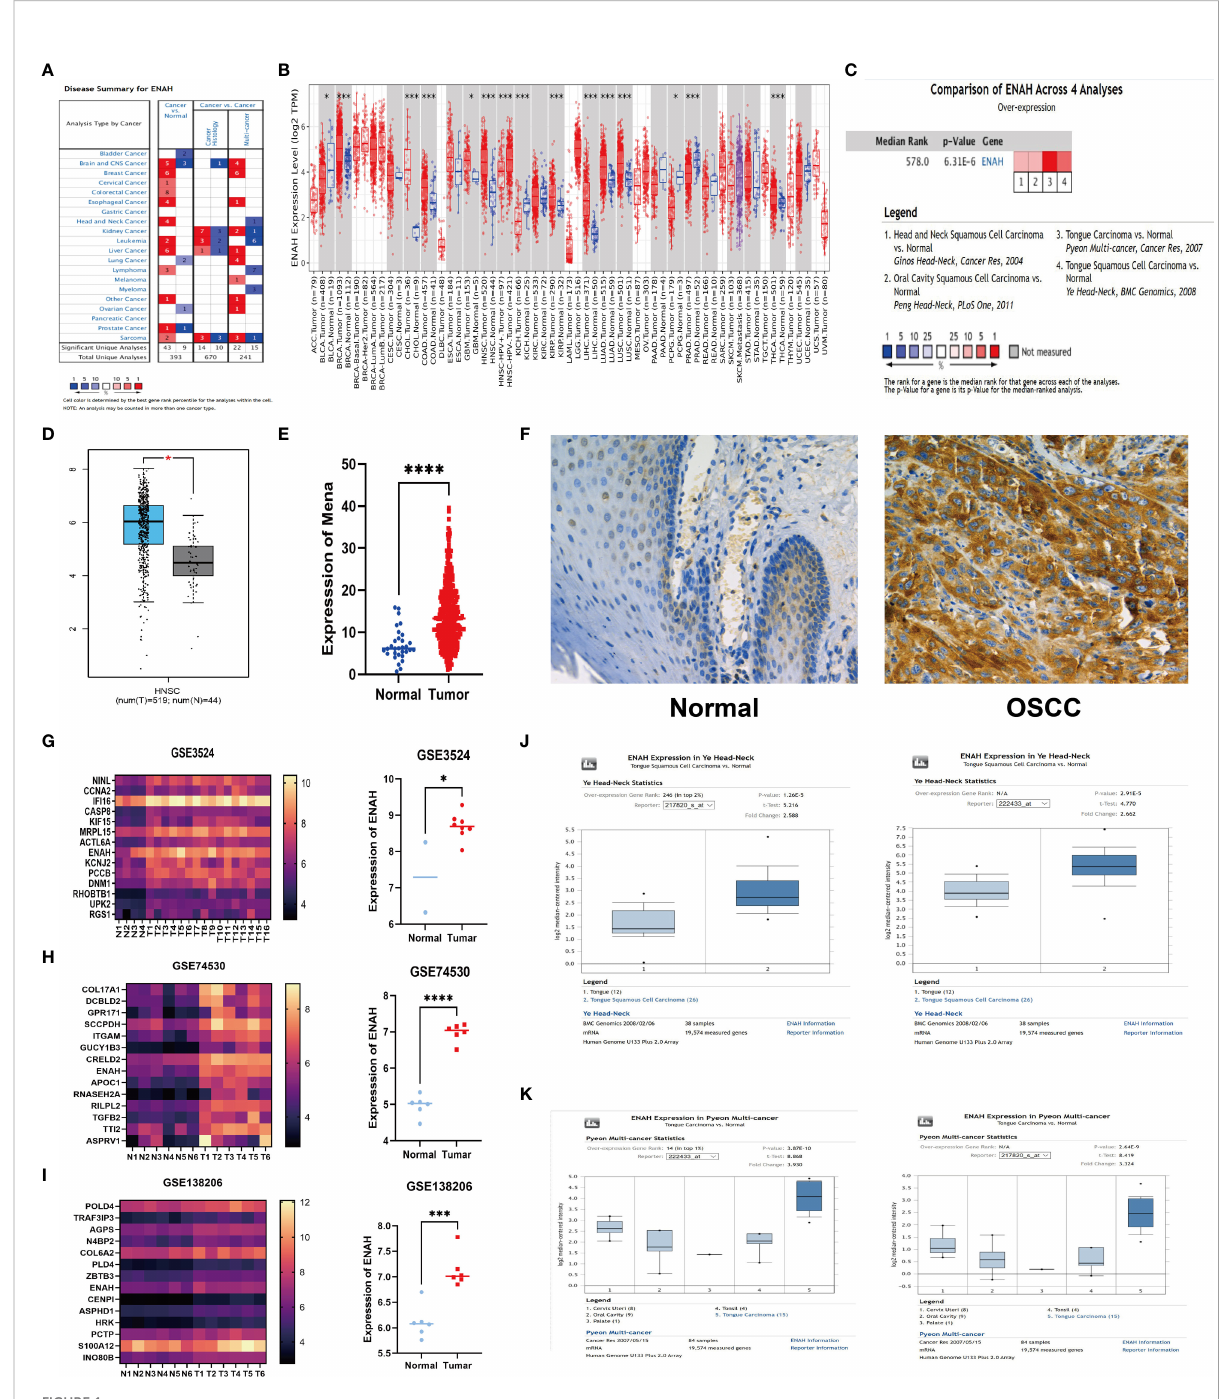
FIGURE 1 The abnormal expression of Mena mRNA between OSCC and normal tissues. (A) The expression of Mena mRNA in malignancies and normal tissues based on Oncomine database. (B) TIMER platform represents the expression of Mena mRNA in malignancies and normal tissues based on TCGA database. (C, D) Higher expression of ENAH (coded Mena) in HNSC tissues than normal tissues. (E) Mena expression between OSCC and normal specimens. (F) IHC staining shows lower or no expression of Mena in normal oral tissues. (G-K) The expression of Mena mRNA in OSCC and normal tissues based on GEO and Oncomine databases. *P < 0.05, ***P < 0.001, ****P < 0.0001 is mentioned in 2.3 statistical